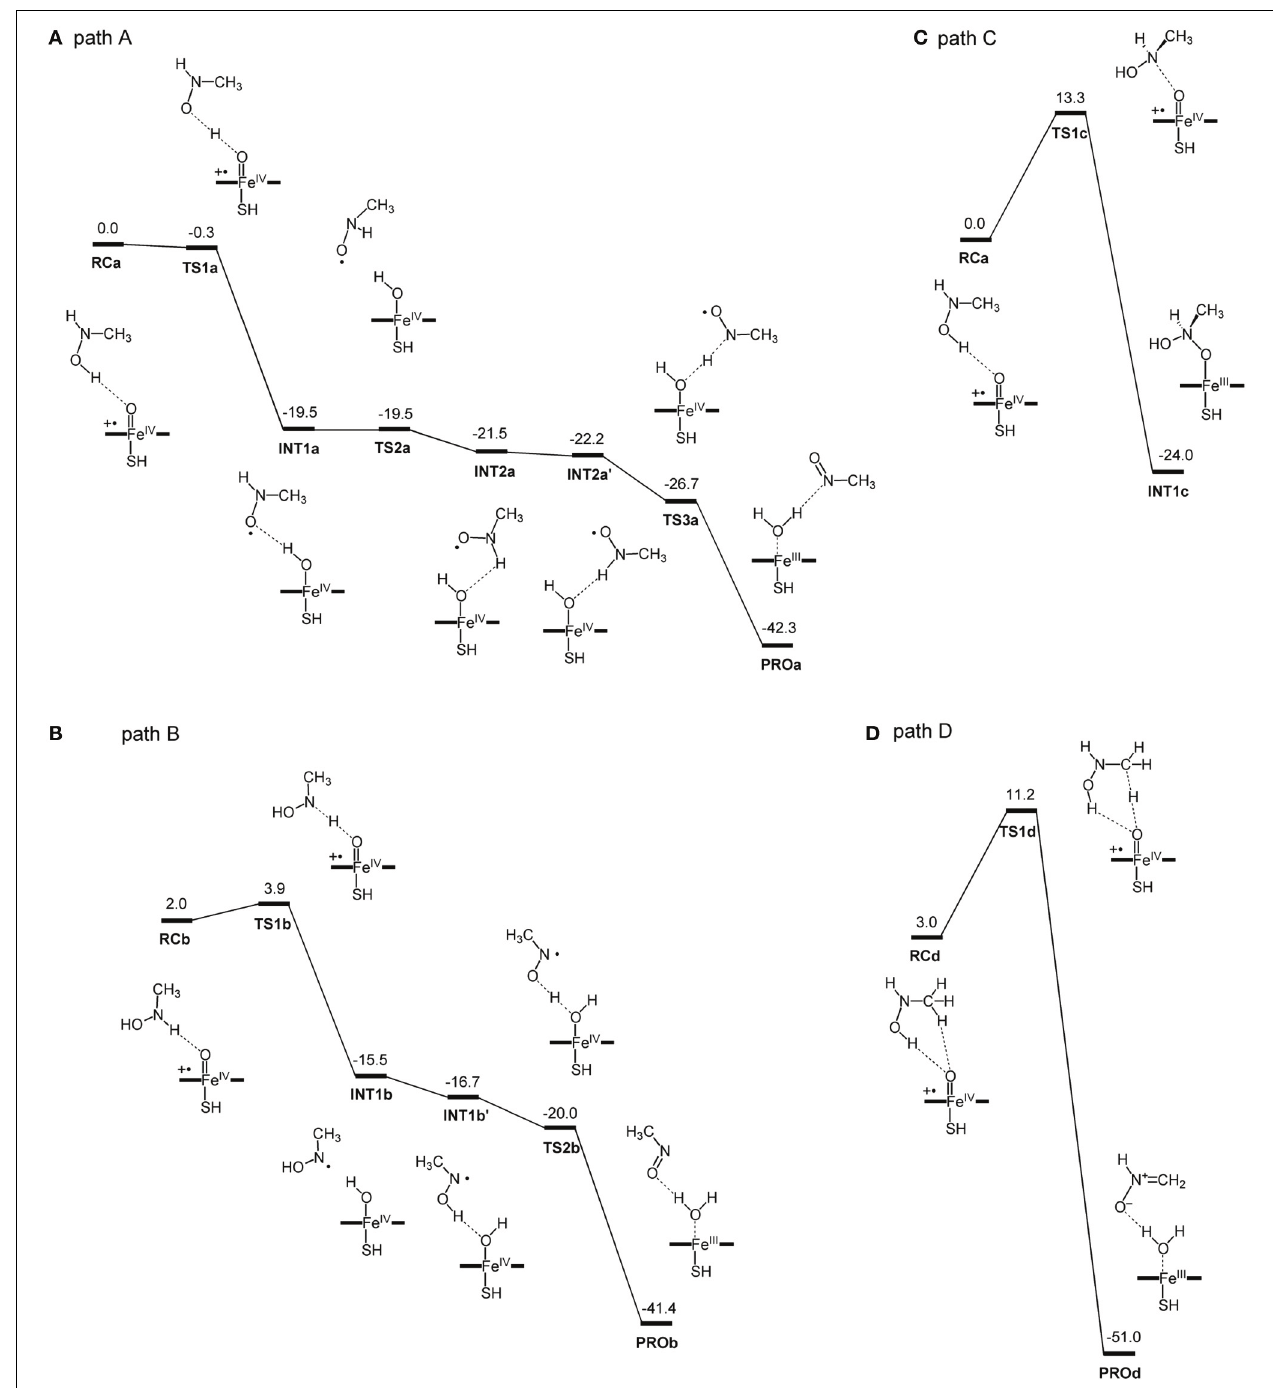
FIGURE 6 | DFT-calculated reaction energy profiles (in kcal/mol) for paths (A–D), which are initiated by H-abstraction from the O–H bond (A), H-abstraction from the N–H bond (B), N-oxidation (C), and H-abstraction from the methyl group (D). Reprinted from Hirao et al.